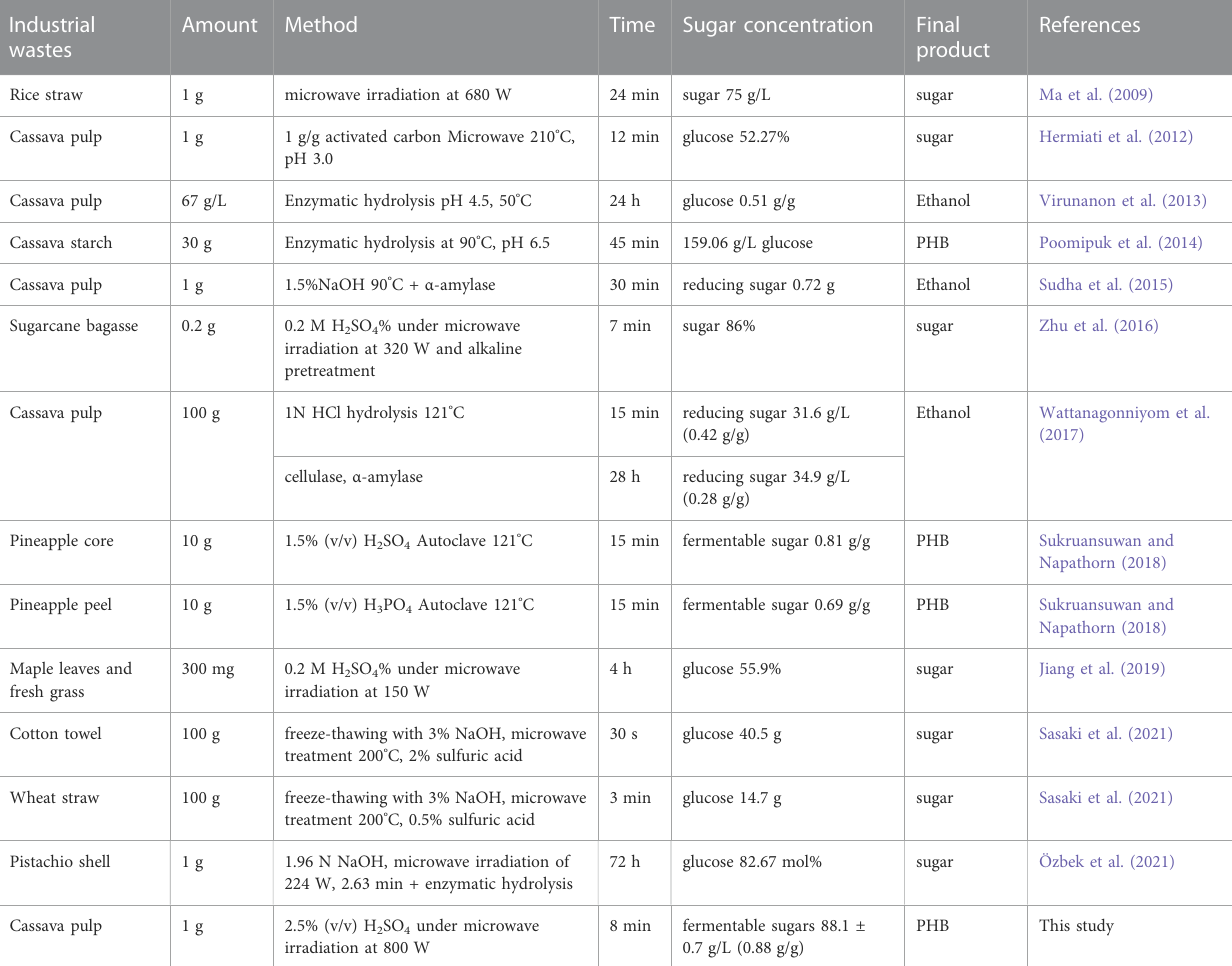
TABLE 5 Comparison of cassava pulp hydrolysis methods for preparation of fermentable sugars. Industrial